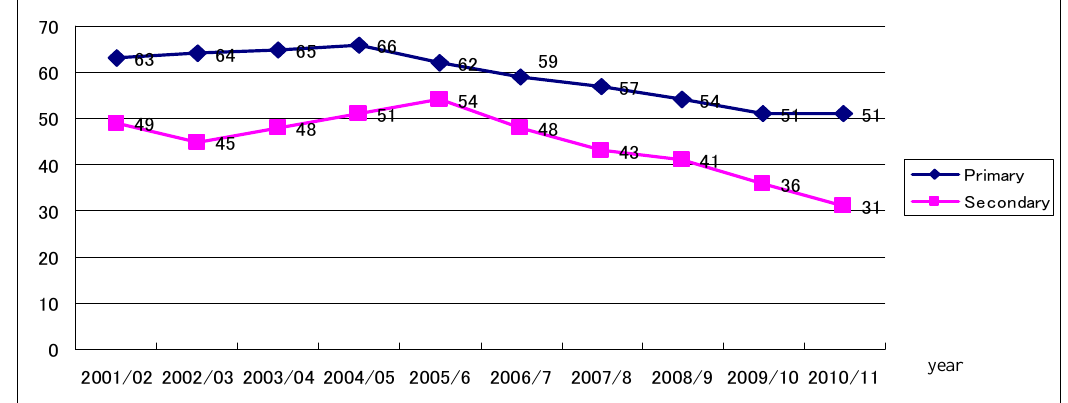
Figure 4-17: Trends of Pupil Teacher Ratio (2001/02 -